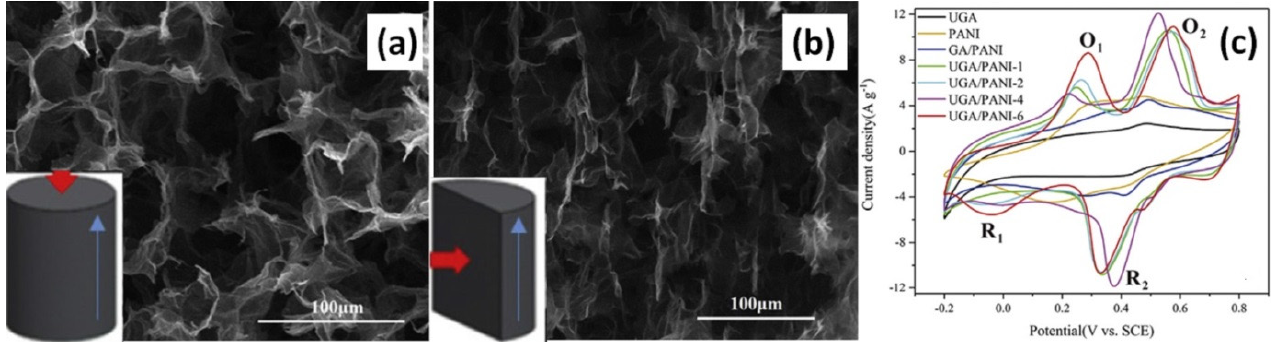
Figure 10. SEM images of UGA in top-view UGA/PANI ( a ), UGA/PANI in side-view ( b ) The blue arrow represents direction of ice crystal growth. CV curves of UGA, PANI, GA/PANI and UGA/PANI composites at a scan rate of 10 mV/s ( c ) (Reprinted from [52], Copyright 2018, with permission from Elsevier).